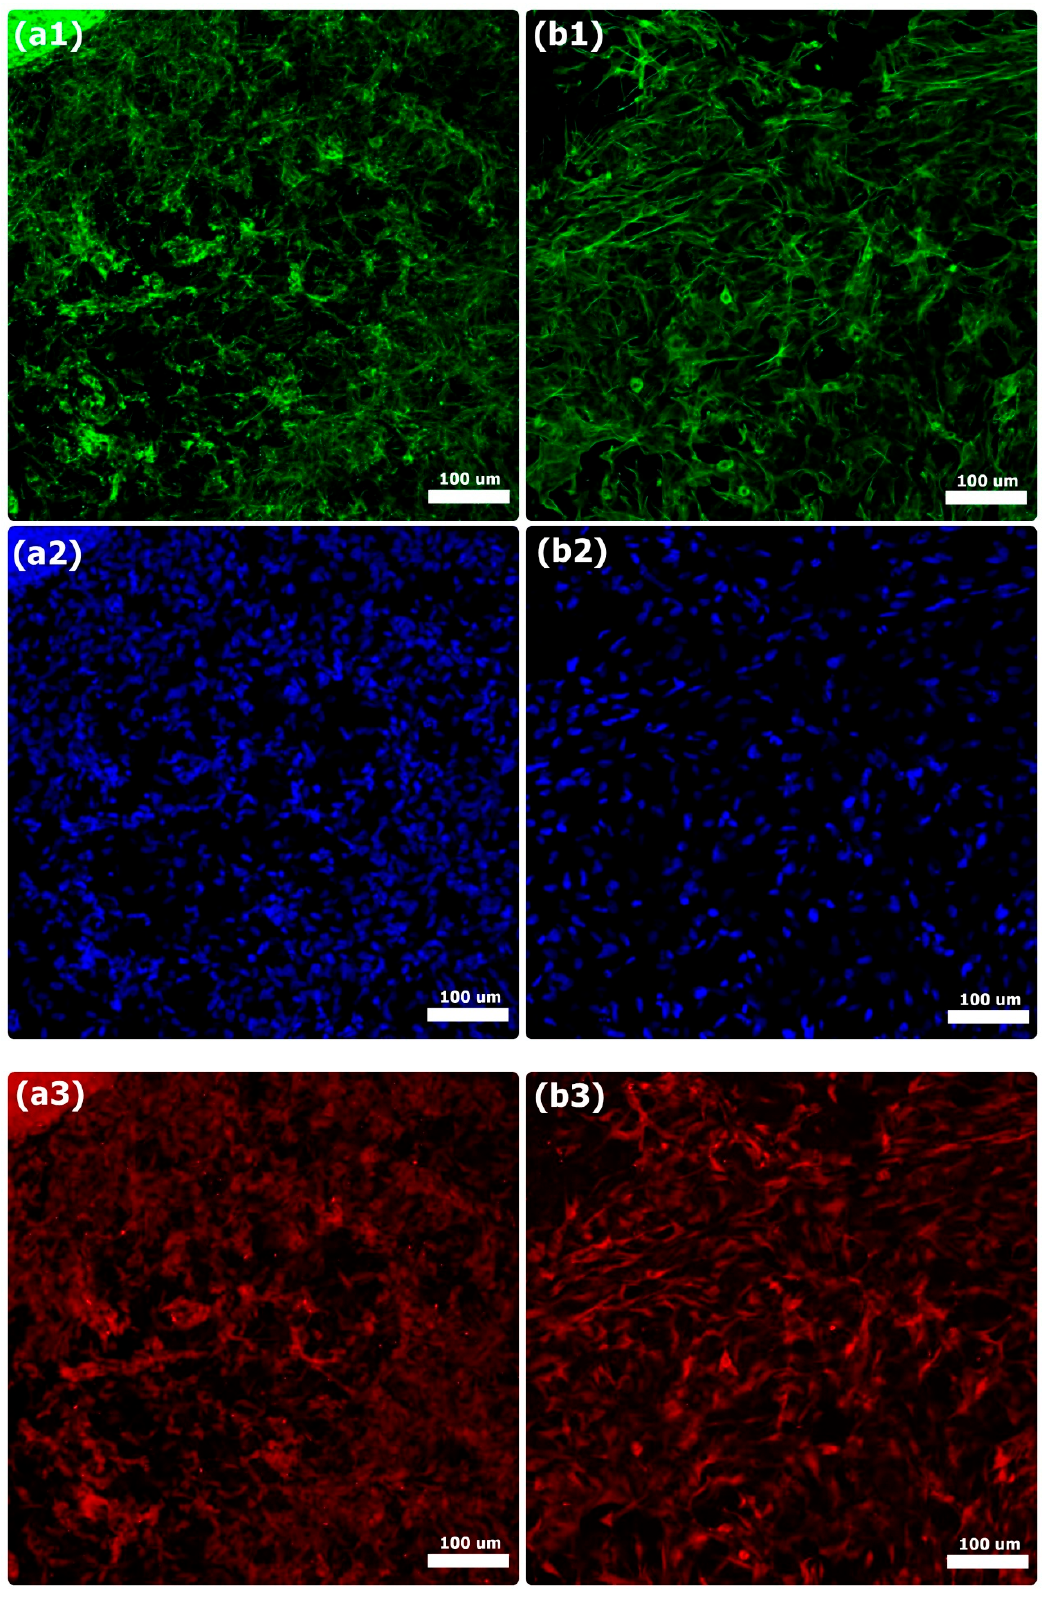
Figure 10. Immunofluorescence analysis of BSP on the ( a1,a2,a3 ) COL scaffold and ( b1,b2,b3 ) COL-HANF scaffold after 14 days of culture. MG63 osteoblast-like cells were stained with BSP (red), cell nuclei were stained with DAPI (blue), and cytoskeletal F-actin was stained with FITC (green). Scale bar = 100 µm.